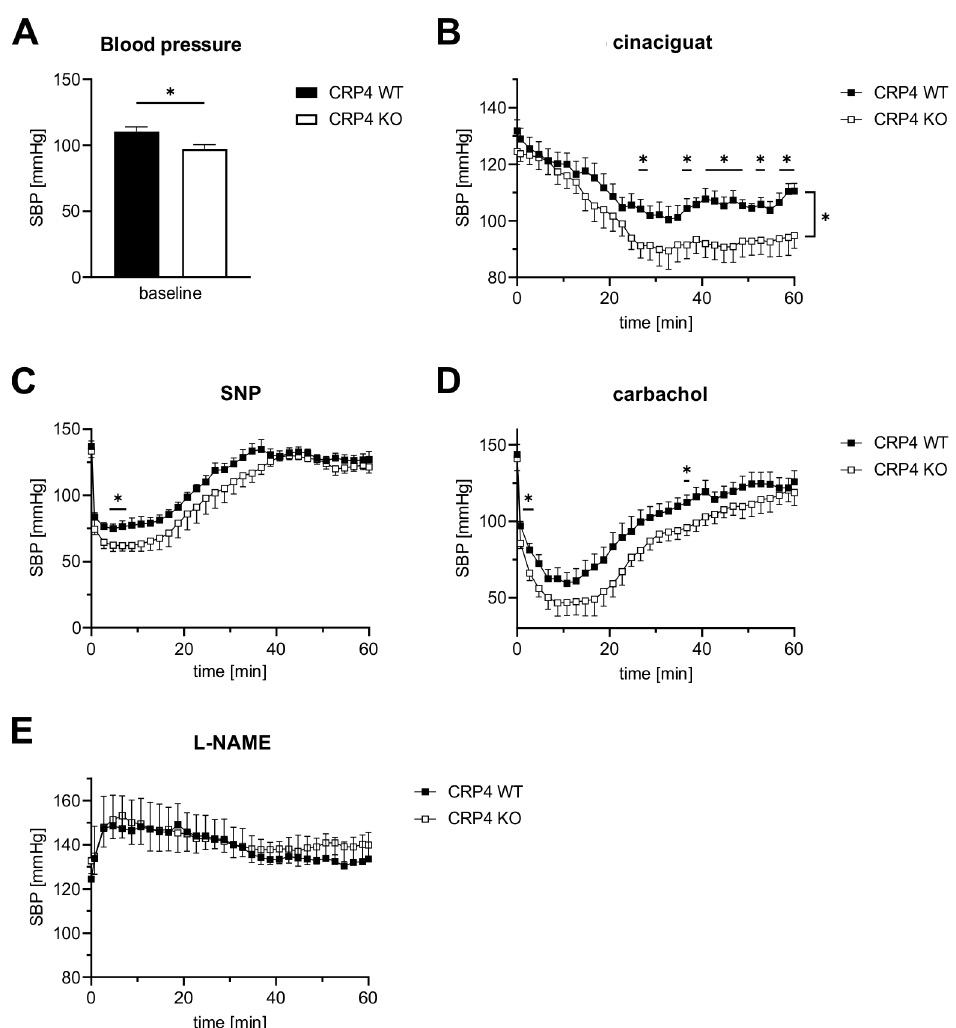
Figure 4. cGMP-mediated blood pressure regulation involves CRP4. ( A ) As previously reported [57], basal systolic BP (SBP) of CRP4 KO mice was significantly lower by 13.1 ± 3.15 mmHg than in CRP4 WT mice. * p < 0.05 represents the statistical difference between WT and CRP4 KO, two-tailed students t -test. ( B ) The NO-GC activator cinaciguat (100 µ g/kg bodyweight, i.p.) induced a significantly higher decrease in SBP in CRP4 KO animals. Data points represent means ± SEM with n = 8 per genotype, * p < 0.05, repeated-measure ANOVA with an uncorrected Fisher’s LSD used as a post hoc test. ( C – D ) Effects of NO-donor sodium nitroprusside (SNP) (2.5 mg/kg bodyweight, i.p.) and the endothelium-dependent vasorelaxant carbachol (0.5 mg/kg bodyweight, i.p.) on SBP were more transient than cinaciguat and resulted in a much faster drop of SBP with consistently significant lower values for CRP4 KO mice. Data points represent means ± SEM with n = 7–8 per genotype for SNP; n = 5 per genotype for carbachol, * p < 0.05, repeated-measure ANOVA with an uncorrected Fisher’s LSD was used as a post hoc test. ( E ) Inhibition of endogenous NO-synthase activity by L-NAME (100 mg/kg bodyweight, i.p.) increased SBP to a similar extent in CRP4 WT and KO mice. Data points represent means ± SEM with n = 5–6 per